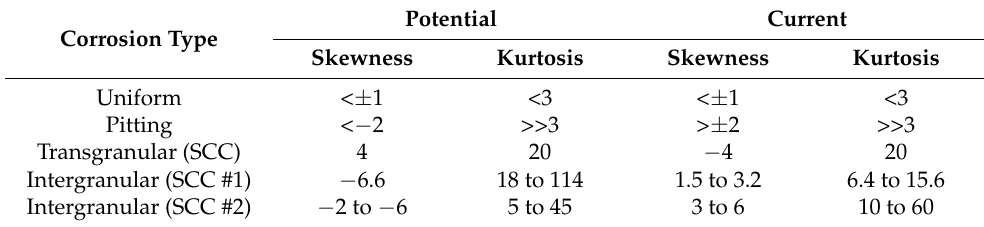
Table 4. Corrosion types evaluated by Kurtosis and skewness